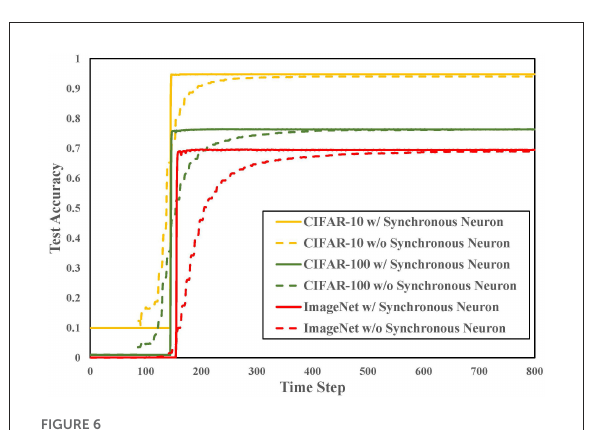
FIGURE6 The performance of spiking ResNet18 on three datasets.